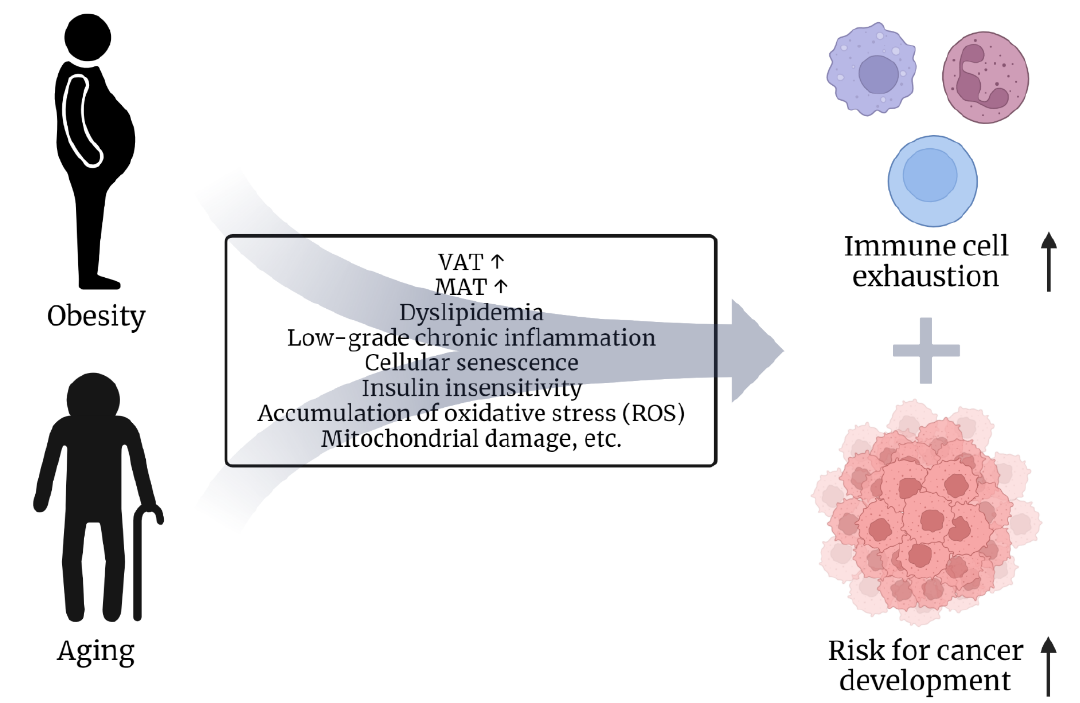
Figure 2. Role of obesity and aging in oncogenesis. Obesity and aging share characteristics. In both conditions, an increase in visceral and bone marrow adipose tissue is observed [37,38,40]. In addition, dyslipidemia [39], low-grade chronic inflammation leading to cellular senescence [31,46], as well as increasing insulin insensitivity [46], accumulation of ROS [46], mitochondrial damage [46] etc., are considered mutual concomitants of obesity and aging. These factors may eventually lead to immune cell exhaustion/dysfunction and an increased risk of developing cancer over time.